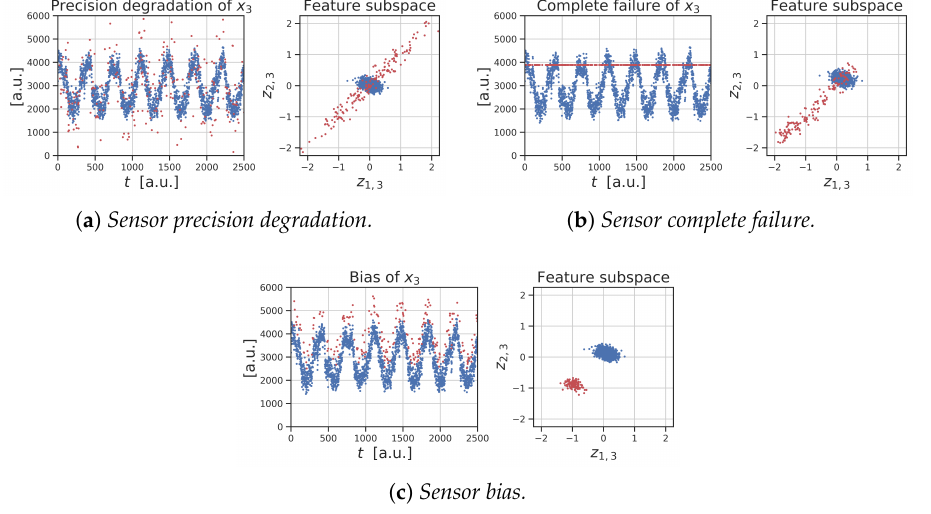
Figure 4. (sx) Synthetic anomalous signal obtained starting from the real signal x 3 of Figure 3. Contamination 10%, anomaly amplitude 1. (dx) Corresponding feature subspace. Synthetic anomalies are red colored. We highlight the effectiveness of the preprocessing block of AD4MPFM that makes anomalous samples lie on the subspace